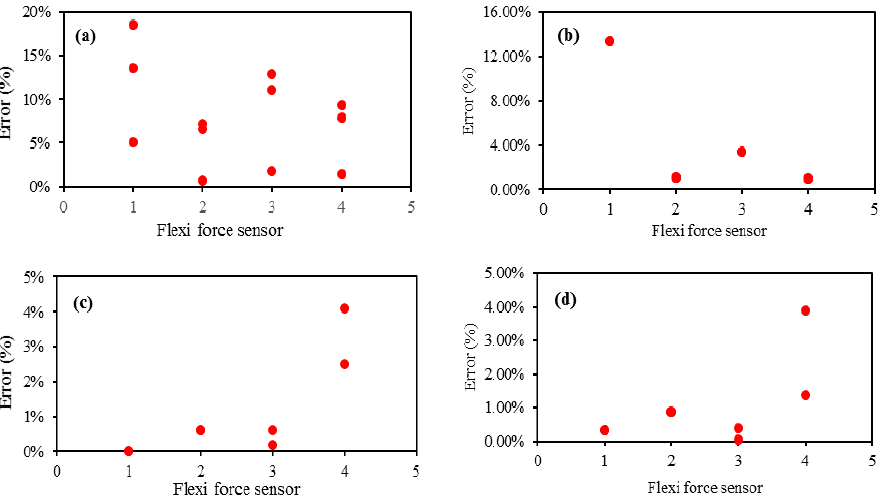
Figure 12. Measured Flexi force sensors error against each sensing position during ( a ) tree posture; ( b ) leaning forward; ( c ) squat; ( d ) forward fold